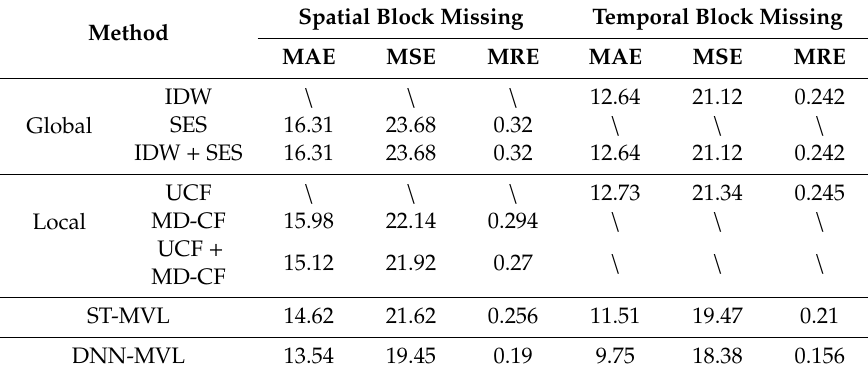
Table 4. Results of different combination methods (dam deformation data).